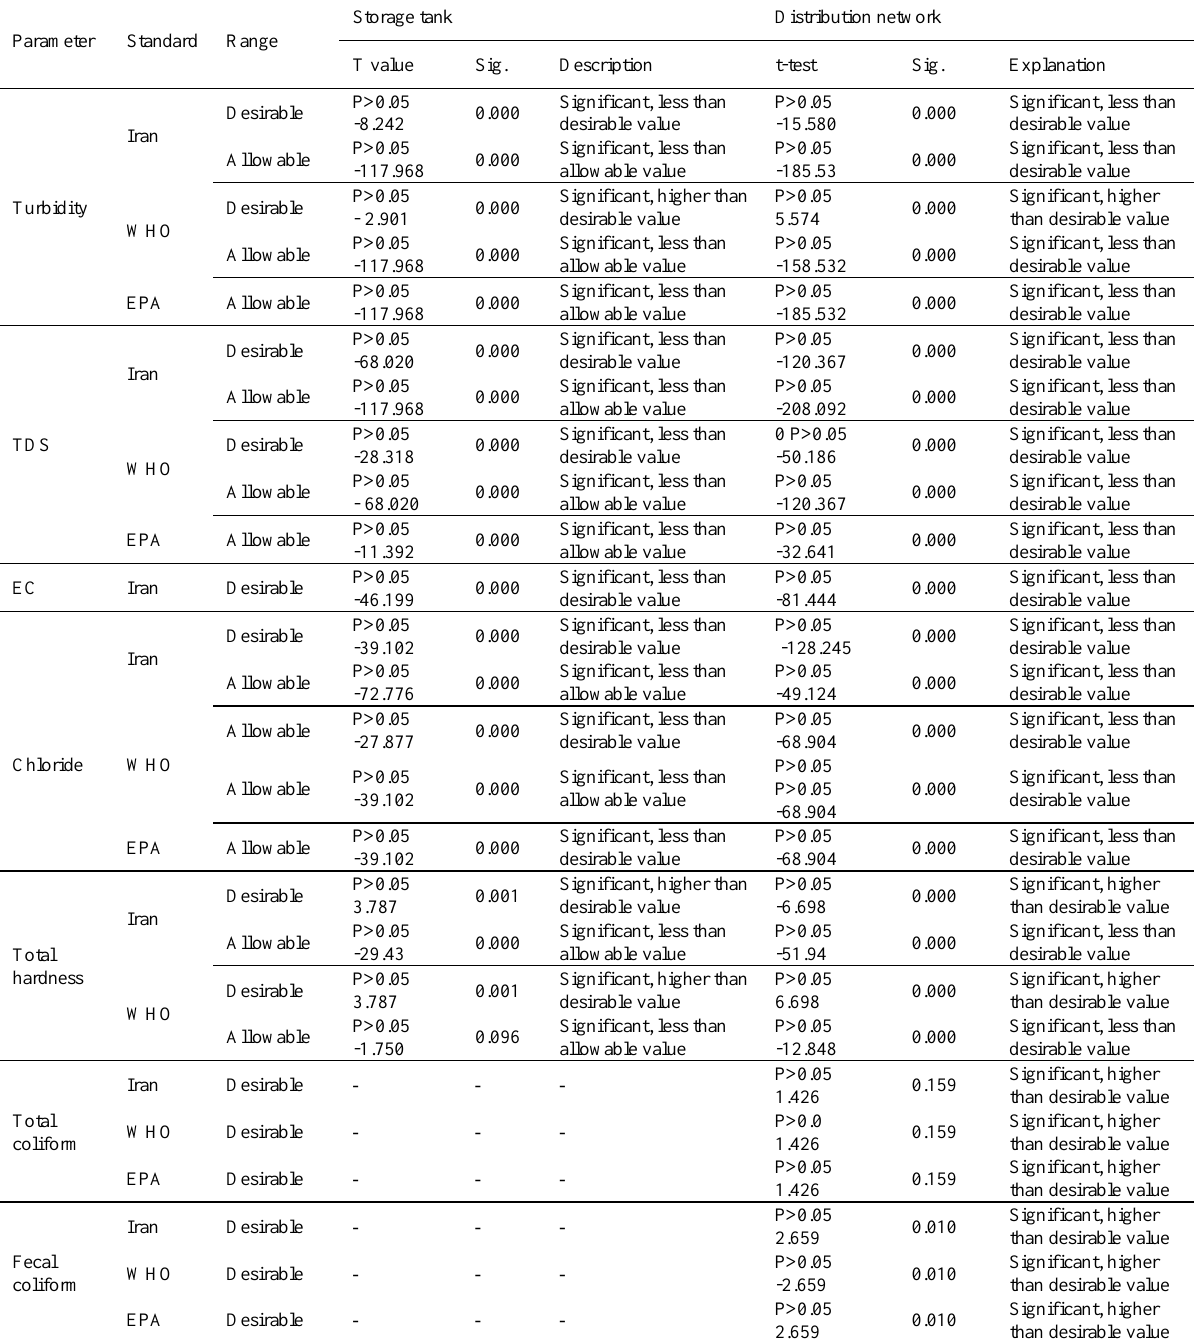
Table 4. One-sample t-test and comparison of mean parameters with desirable and standard values